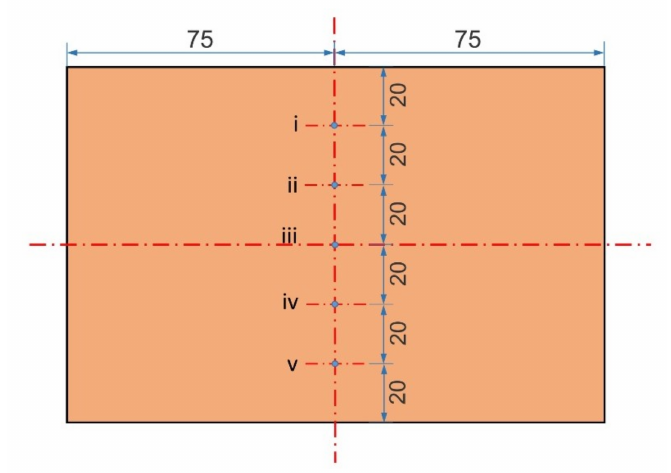
Figure 2. Measurement position of the surface roughness and morphology of cathode copper (Unit: